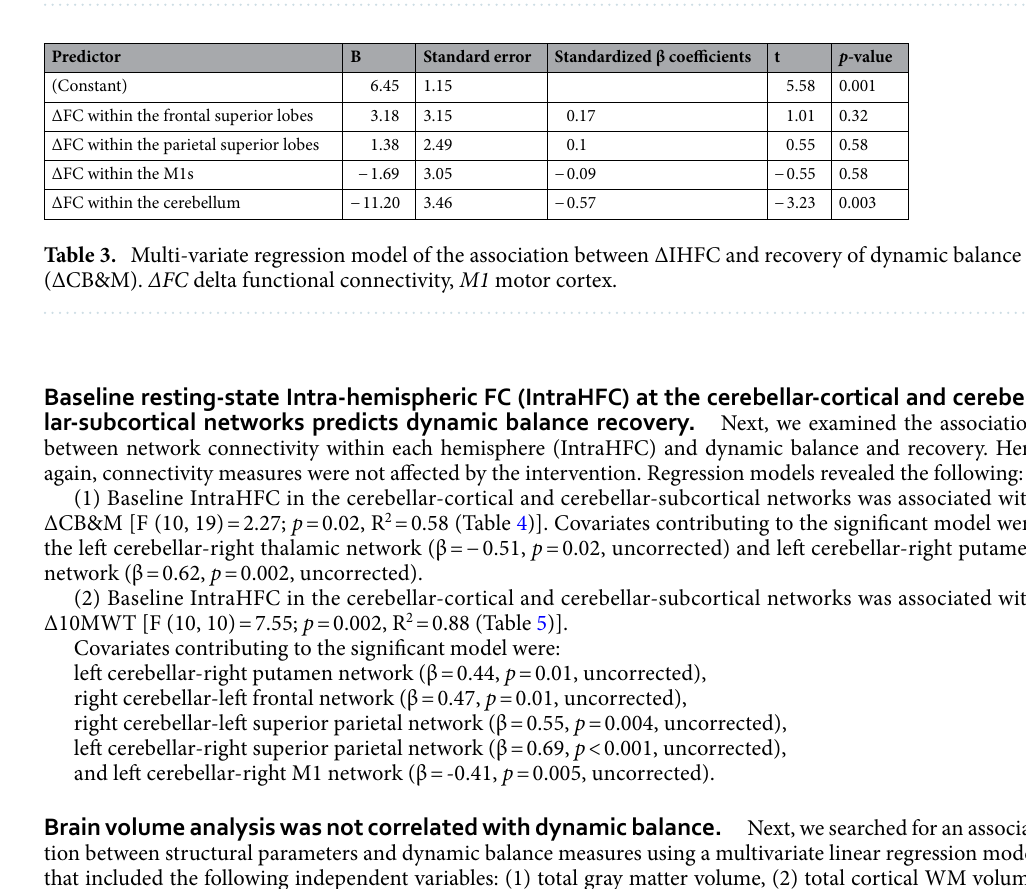
Figure 1. Two resting-state networks of interest identified by ICA: Sensorimotor (left) and Cerebellar (right). ( A ) Left, ICA component corresponding to the sensorimotor network. right, ICA component corresponding to the cerebellar network (transverse brain section-right figure), (coronal brain section-left figure). ( B ) Contrasts of both networks between pre (T1) and post-intervention (T2). Left, Sensorimotor network. Right, Cerebellar network (axial section (left) and coronal section (right). Color maps represent voxels’ significance. N = 31.